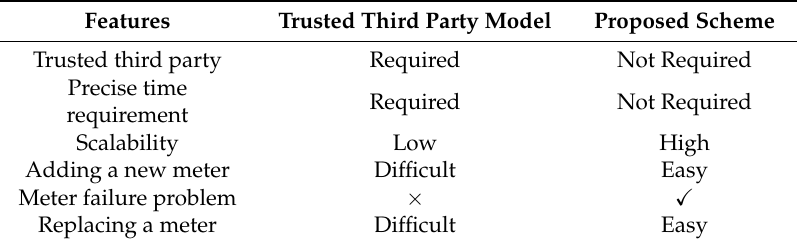
Table 1. Comparison of trusted third party model and proposed scheme.